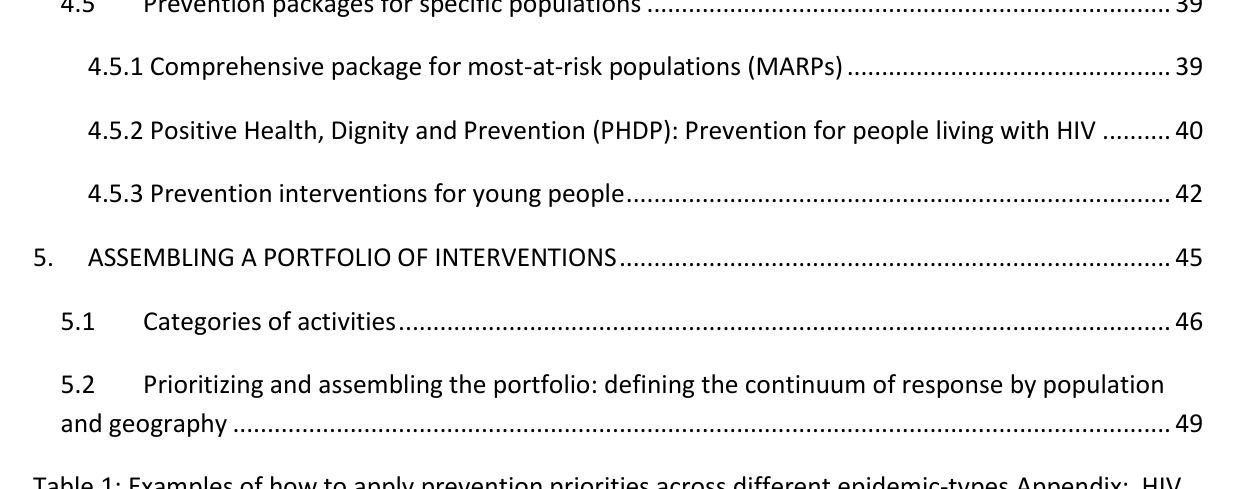
Table 1: Examples of how to apply prevention priorities across different epidemic-types.Appendix: HIV prevention and the Global Health Initiative (GHI): connecting to the broader country continuum of